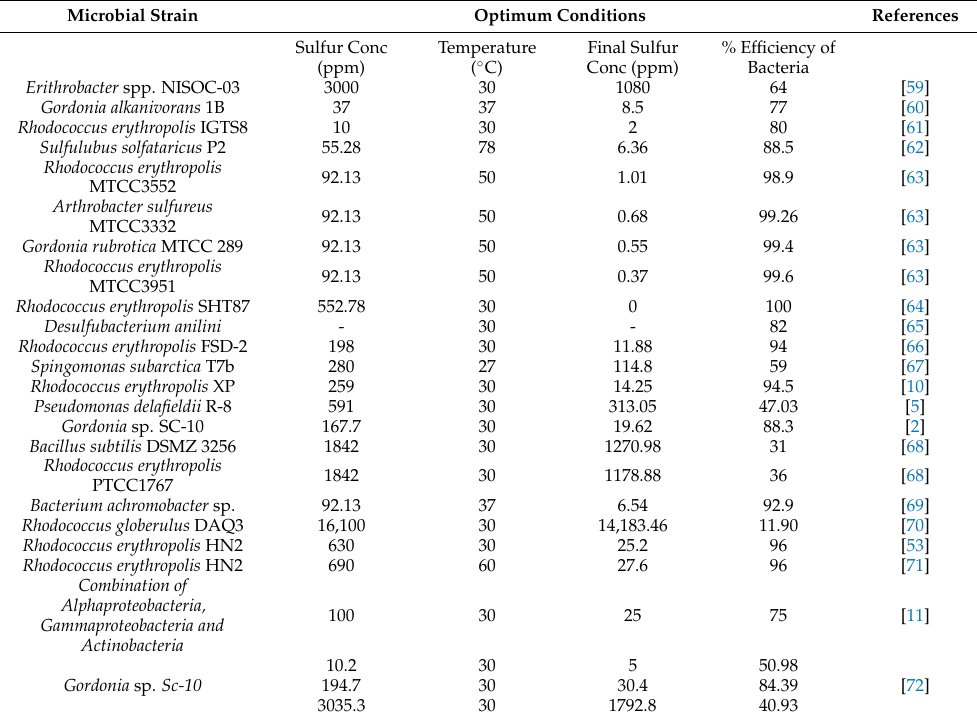
Table 1. Microbial strains capable of desulfurizing